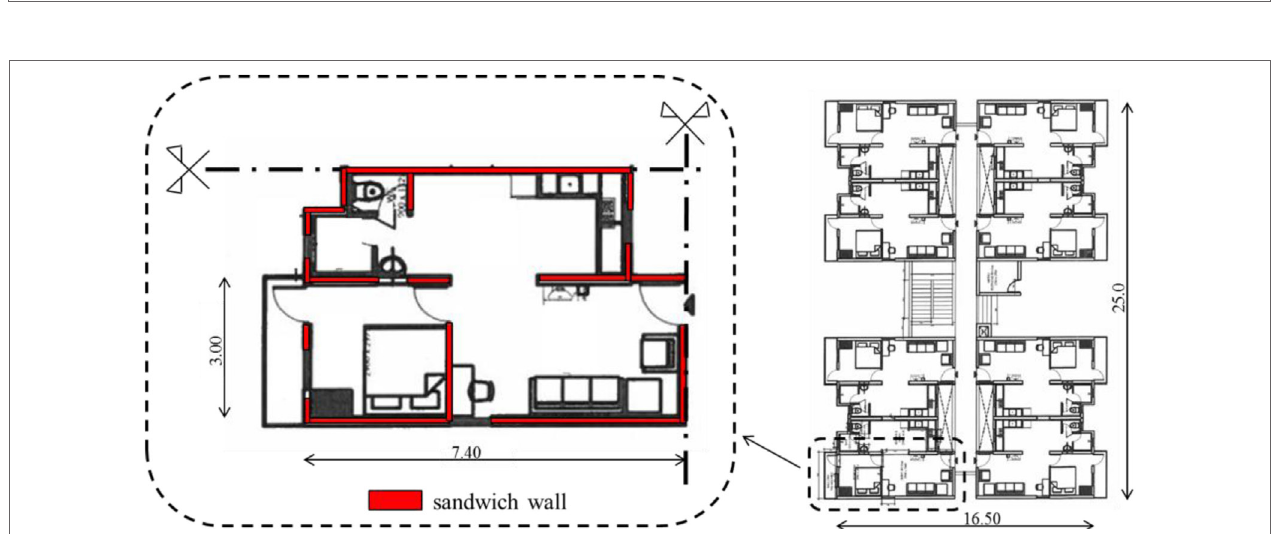
FigURe 13 | Typical apartment and typical floor of the residential buildings designed in